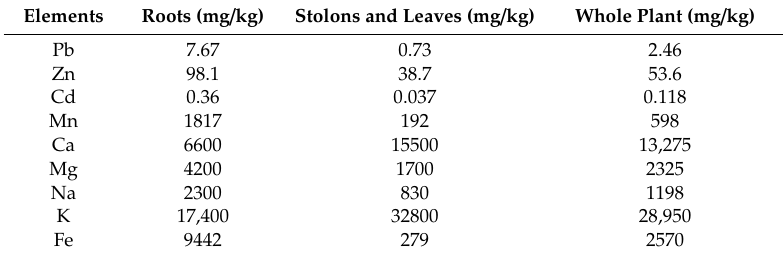
Table 1. Contents of main elements in the collected Eichhornia crassipes .